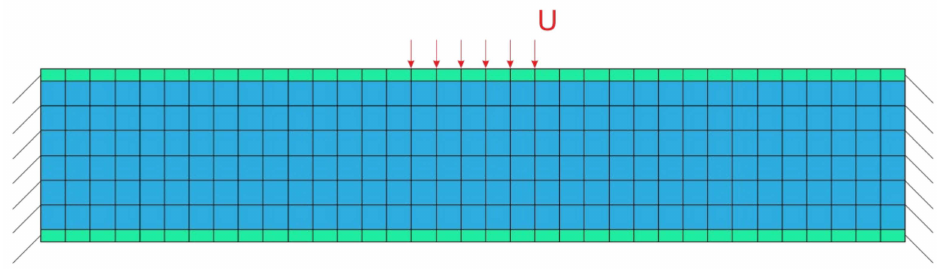
Figure 2. Loading scheme; U is applied displacements; the green region is V con